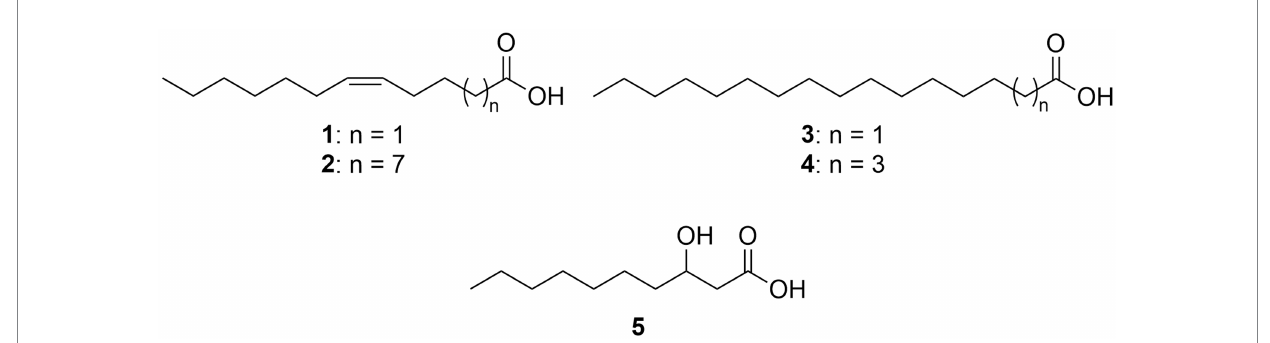
FIGURE 1 Total fatty acids of outer membrane vesicles of Dinoroseobacter shibae